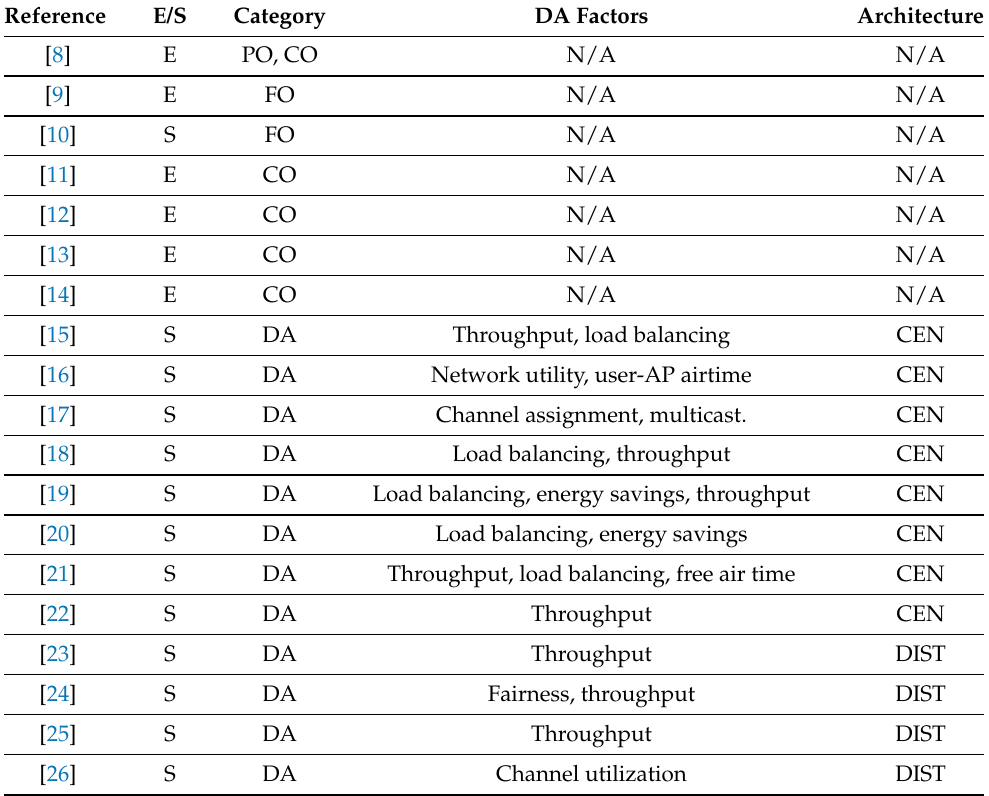
Table 1. An overview of the related works on offloading schemes, cryptographic optimizations, and device association (DA). ‘DA factors’ refer to the input an implementation needs to perform DA (only applicable for works covering DA). E: Experimental. S: Simulated. PO: Partial offloading. FO: Full offloading. CO: Cryptographic optimization. CEN: Centralized. DIST: